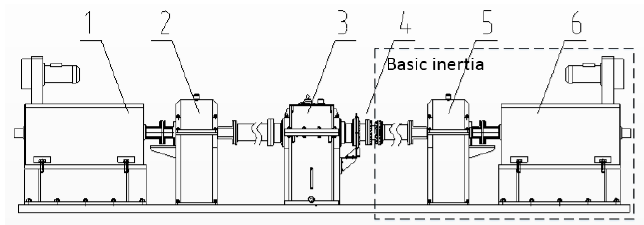
Figure 20. Structure of a basic inertia calibration test.